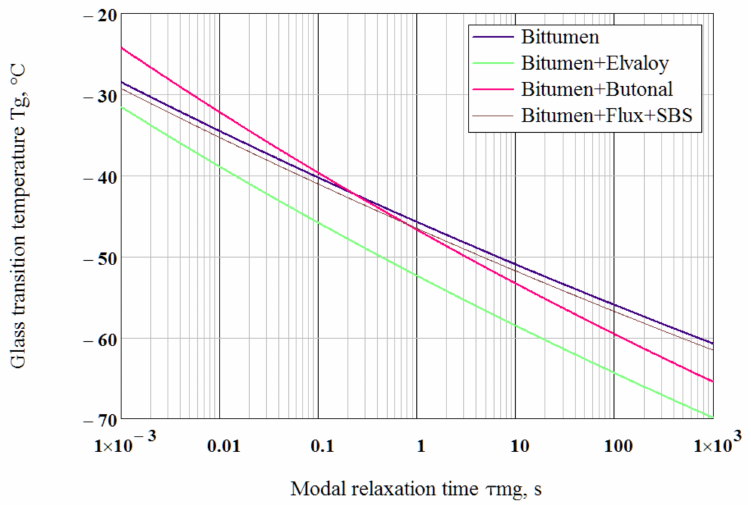
Figure 10. Dependence of glass transition temperature on modal relaxation